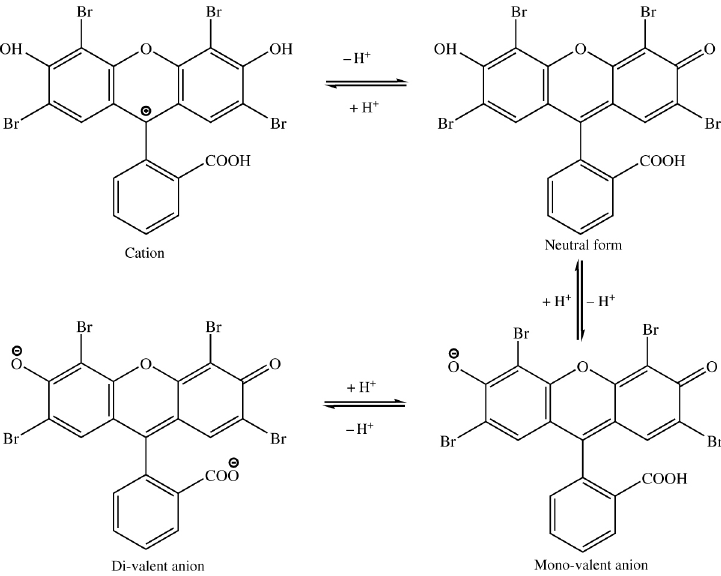
Figure 2: The changes of the structure of eosin Y molecule based on the pH of the medium. where R represents the anionic part of eosin Y. The reported (Batistela et al. 2011) values for pK pK of eosin Y were 2.10, 2.85 and 4.95, respectively. In a weak acidic medium (pH 3.0 – 4.5), eosin Y exists mainly a3